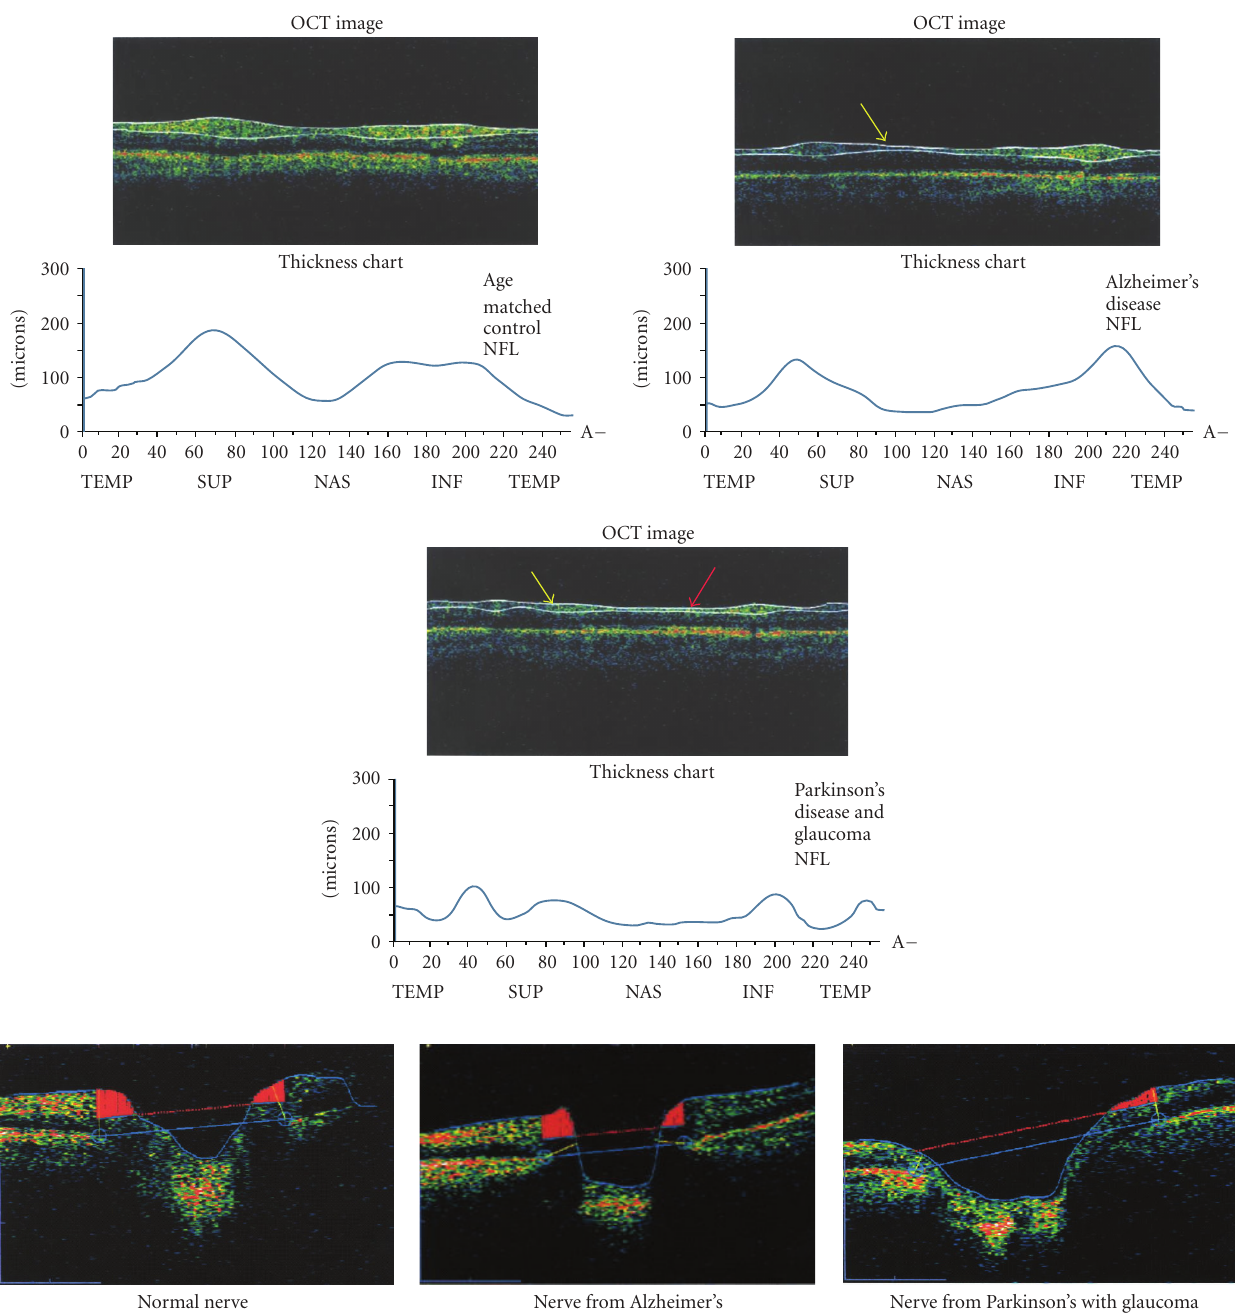
Figure 1: The top three images depict the nerve fiber layer (NFL) generated by the older technology; Stratus-OCT. The y axis is NFL thickness in microns and the x axis is the circumference of the optic nerve in degrees; TEMP = temporal, SUP = superior, NAS = nasal and INF = inferior. None of the participants had a significant refractive error. The top left figure is from a 73 year old control participant with no known risk factors for glaucoma; Caucasian and age matched to the AD participant. The NFL had an average thickness of 101 microns. The top right image was obtained from a 72 year old participant with no known risk factors for glaucoma; Caucasian, with AD. The NFL had an average thicknessof 75 microns.The middle image was from a Caucasianparticipant, with no known risk factors for glaucoma; that had both Parkinson’s disease and glaucoma. The average NFL thickness was 58 microns. The yellow arrows show regions of thinning hypothesized to be due to retrograde neurologic degeneration. The red arrow indicates areas of thinning attributed to glaucoma. The bottom three images are cross sections of the optic nerve. Sections of red indicate the nerve fiber layer. The bottom left image is of the control participant, the bottom middle image is of the AD participant and the bottom right image is of the participant with both Parkinson’s disease and